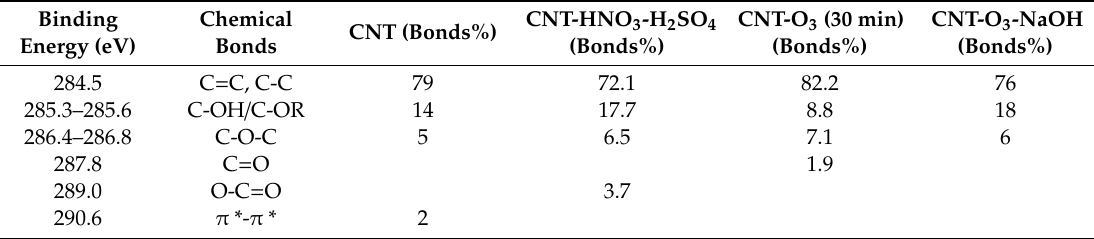
Figure 3. C1s peak deconvolution of ( a ) original CNTs; ( b ) CNTs treated with HNO 3 -H 2 SO 4 ; ( c ) CNTs treated with O 3 -30 min and ( d ) CNTs treated with O 3 -NaOH. Table 3. Bonds composition (%) of CNTs treated with HNO 3 -H 2 SO 4 , O 3 and O 3 -NaOH.